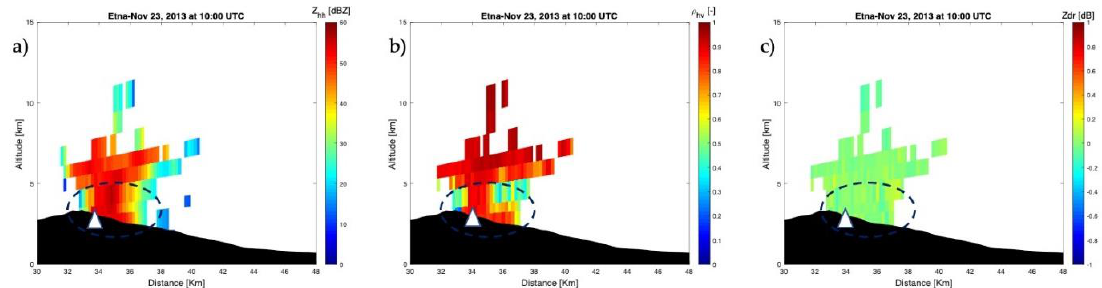
Figure 5. X-Band radar retrieval of Etna explosive activity of 23 Nov. 2013 at 10:00 UTC. Range-Height Indicator (RHI) of the reflectivity factor Z hh (dBZ) in panel ( a ), copolar correlation coe ffi cient ρ hv (admin) in panel ( b ) and in ( c ) Z dr (dB) of X-band radar along the radar azimuth intercepting the volcanic vent. The white triangle identifies the position of the